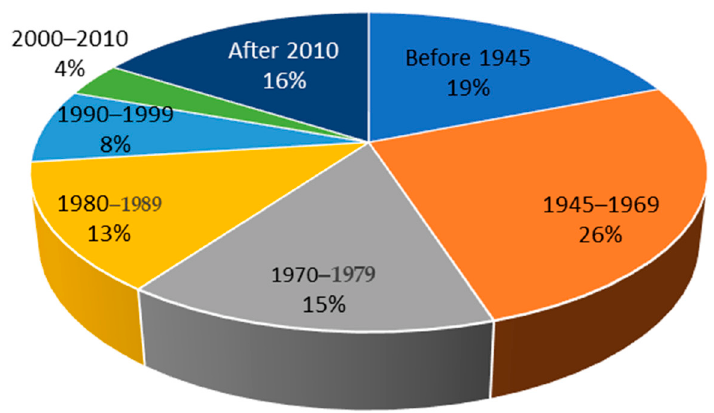
Figure 1. Distribution of Bulgarian building stock (residential and public service buildings) for each period of construction [5].